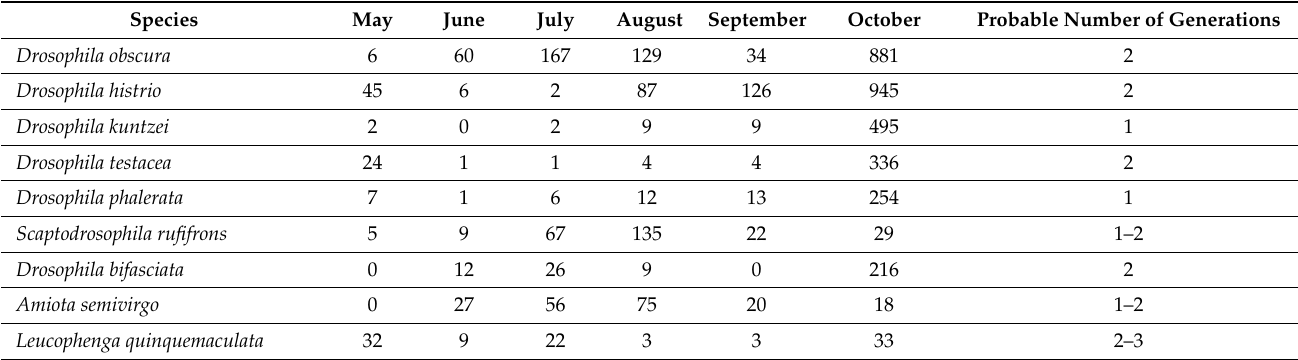
Table 7. Total month-to-month numbers of Drosophilidae in